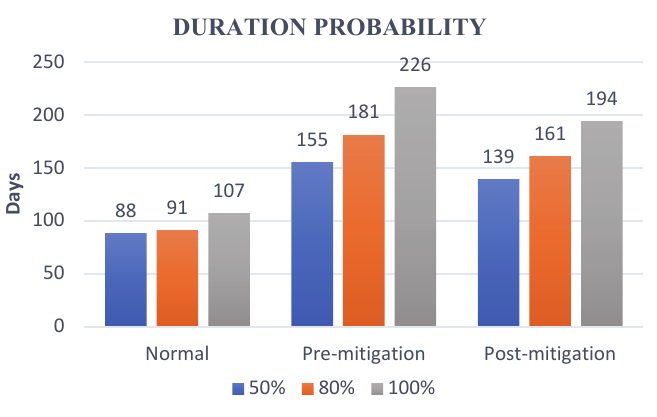
Fig. 7. Risk Matrix (a)Pre-mitigation (b)Post-mitigation